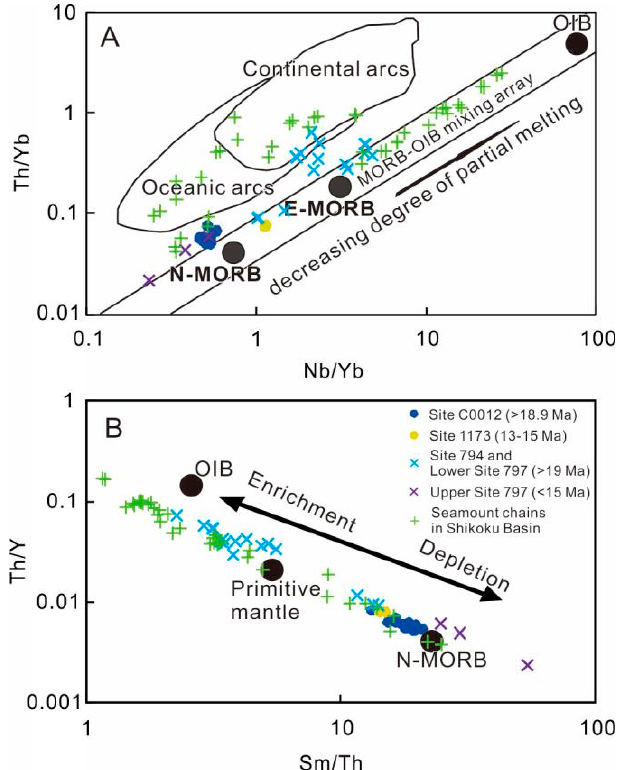
Figure 14. Plots of Th/Yb versus Nb/Yb ( A ) and Th/Y versus Sm/Th ( B ) for the Site C0012 and 1173 volcanic rocks from the Shikoku Basin. Data sources as for Figure 6. Figure 14A is modified from Reference [79]. Figure 14B is modified from Reference [80], the data of PM, OIB, and N-MORB are from Reference [56].